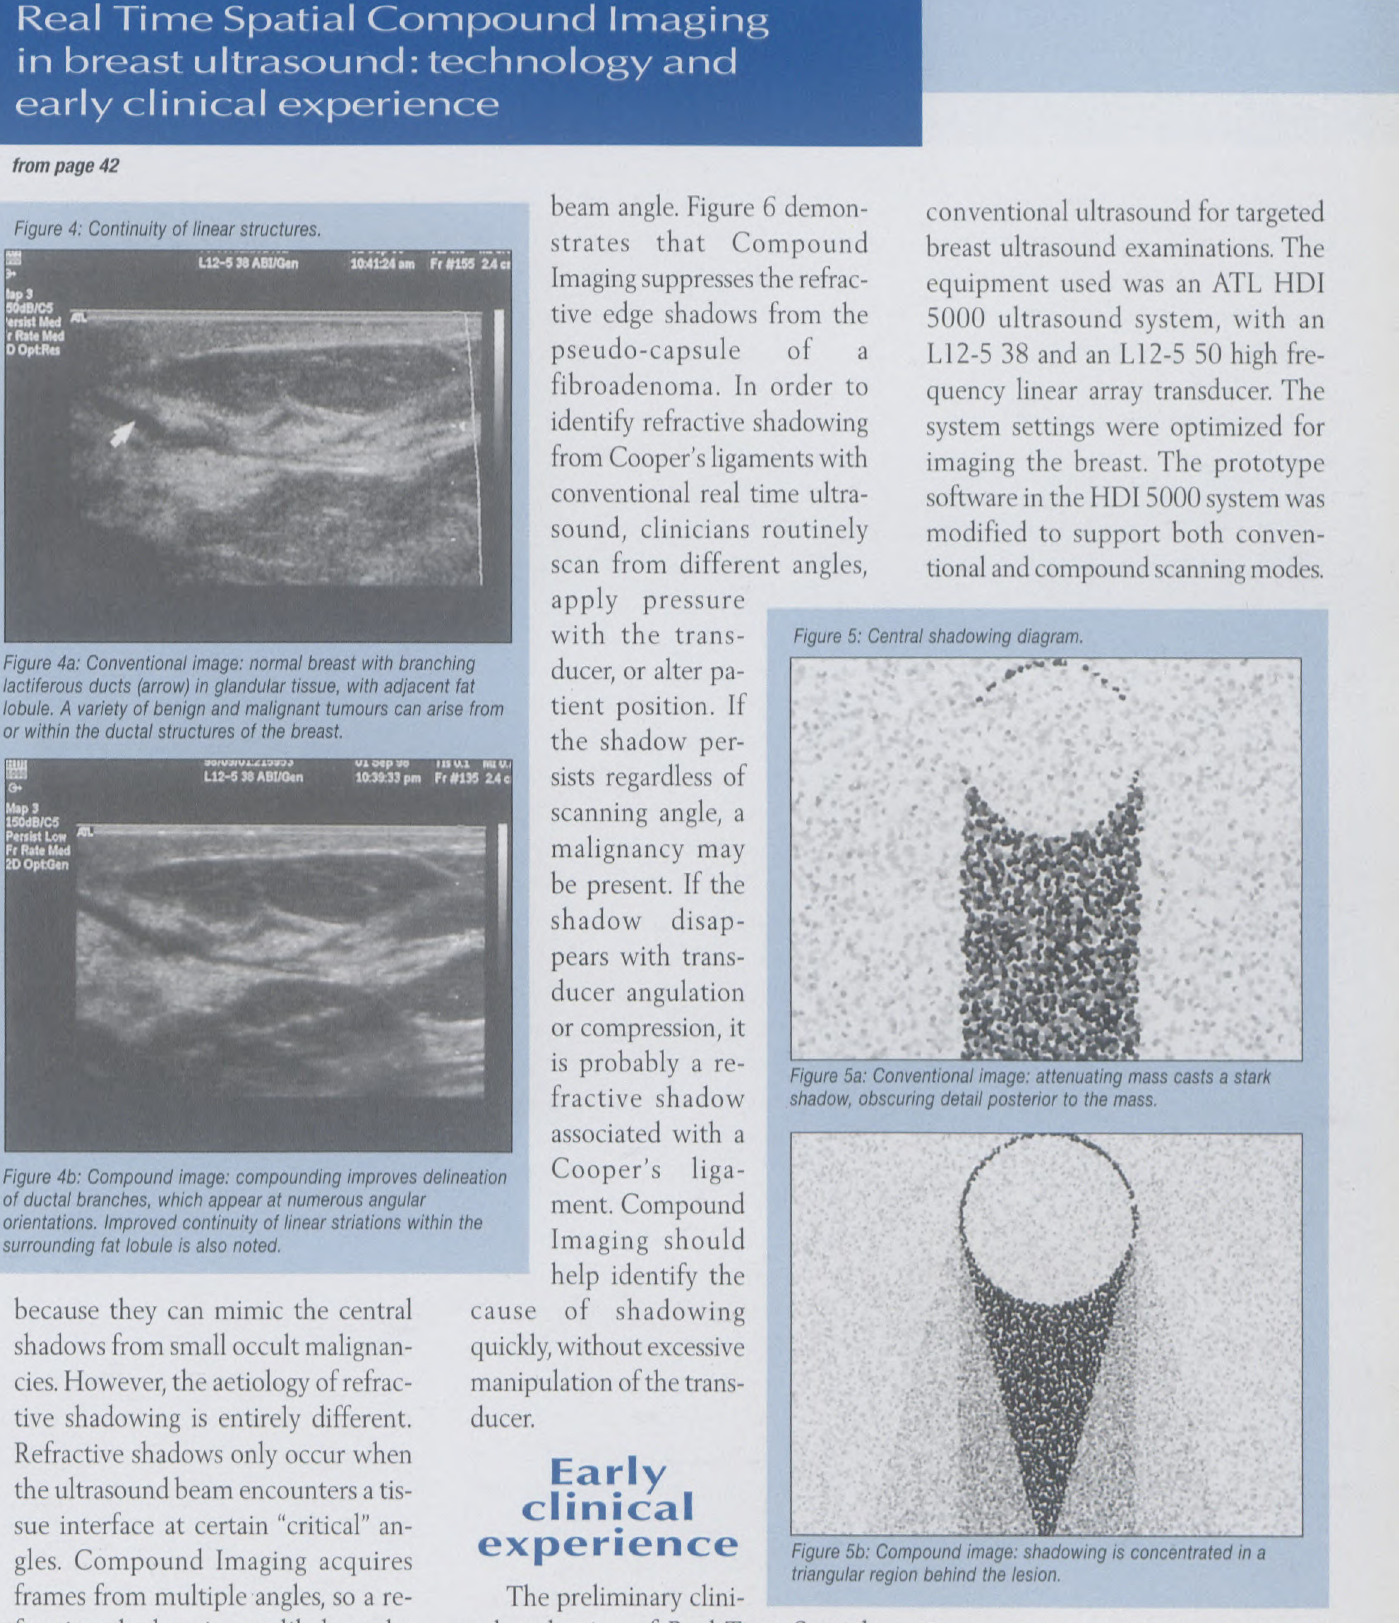
Figure 5b: Compound image: shadowing is concentrated in a triangular region behind the